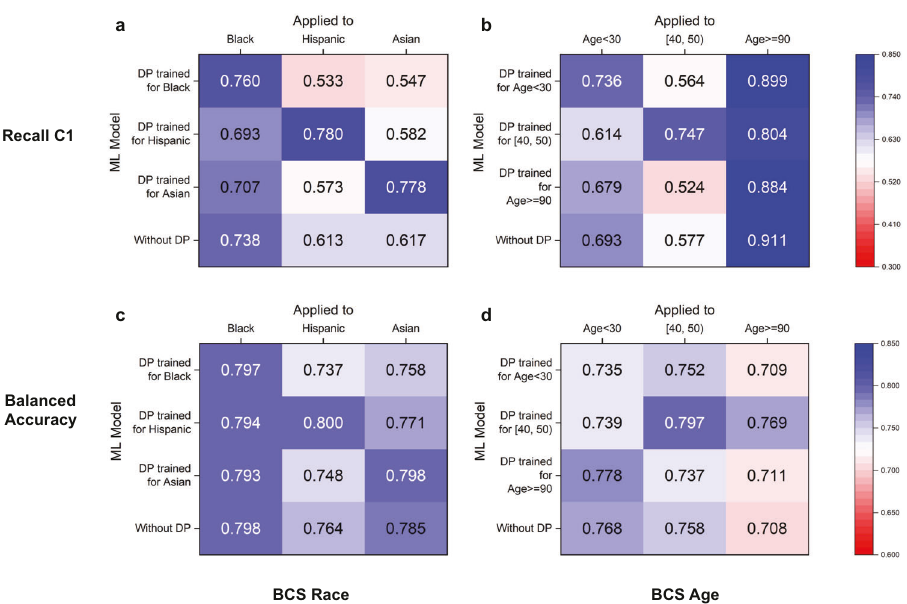
Fig. 8 DP ’ s cross-group performance under various race and age settings for recall C1 and balanced accuracy in BCS prediction. In sub fi gures, each row corresponds to a DP model trained for a speci fi c subgroup. Each column represents a subgroup that a model is evaluated on. The values on the diagonal are the performance of a matching DP model, i.e., a DP model applied to the subgroup that it is designed for. The last rows show the group ’ s performance in the original model. To prevent over fi tting, our method chooses optimal thresholds based on whole group performance. DP cross-group performance for a race subgroups and b age subgroups for the BCS prediction in terms of recall C1. DP cross-group performance for c race subgroups and d age subgroups for the BCS prediction in terms of balanced